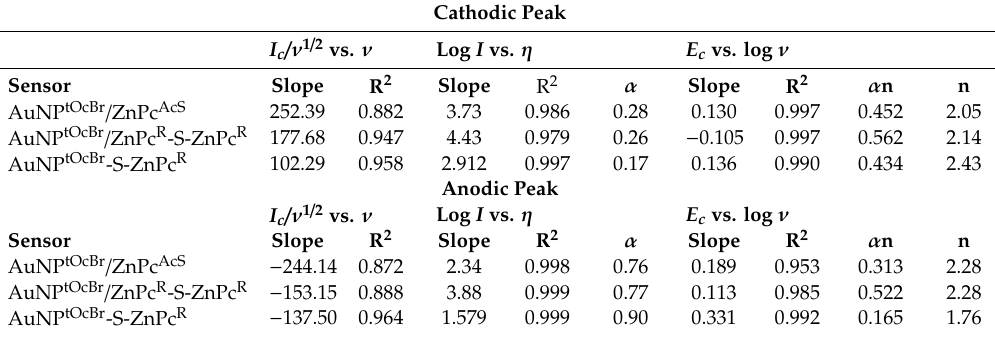
Table 2. Relationship with scan rate in sensors immersed in catechol 10 − 4 mol · L − 1 . Cathodic Peak I c / ν 1 / 2 vs.